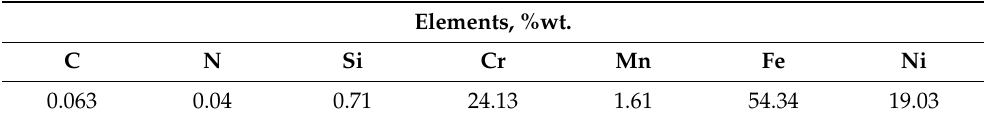
Table 1. Chemical composition of 310 H